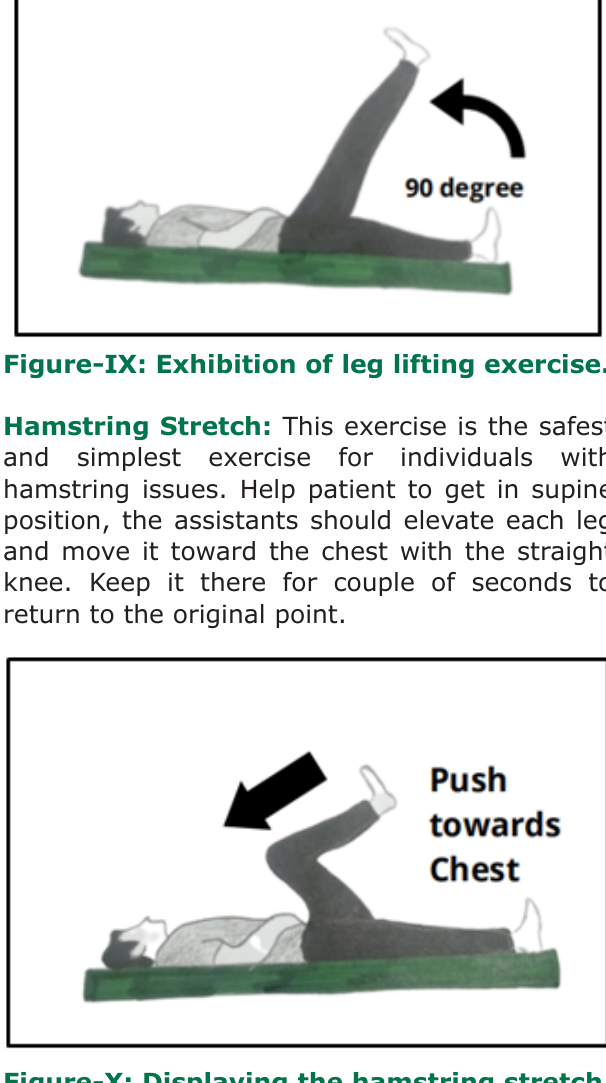
Figure-X: Displaying the hamstring stretch